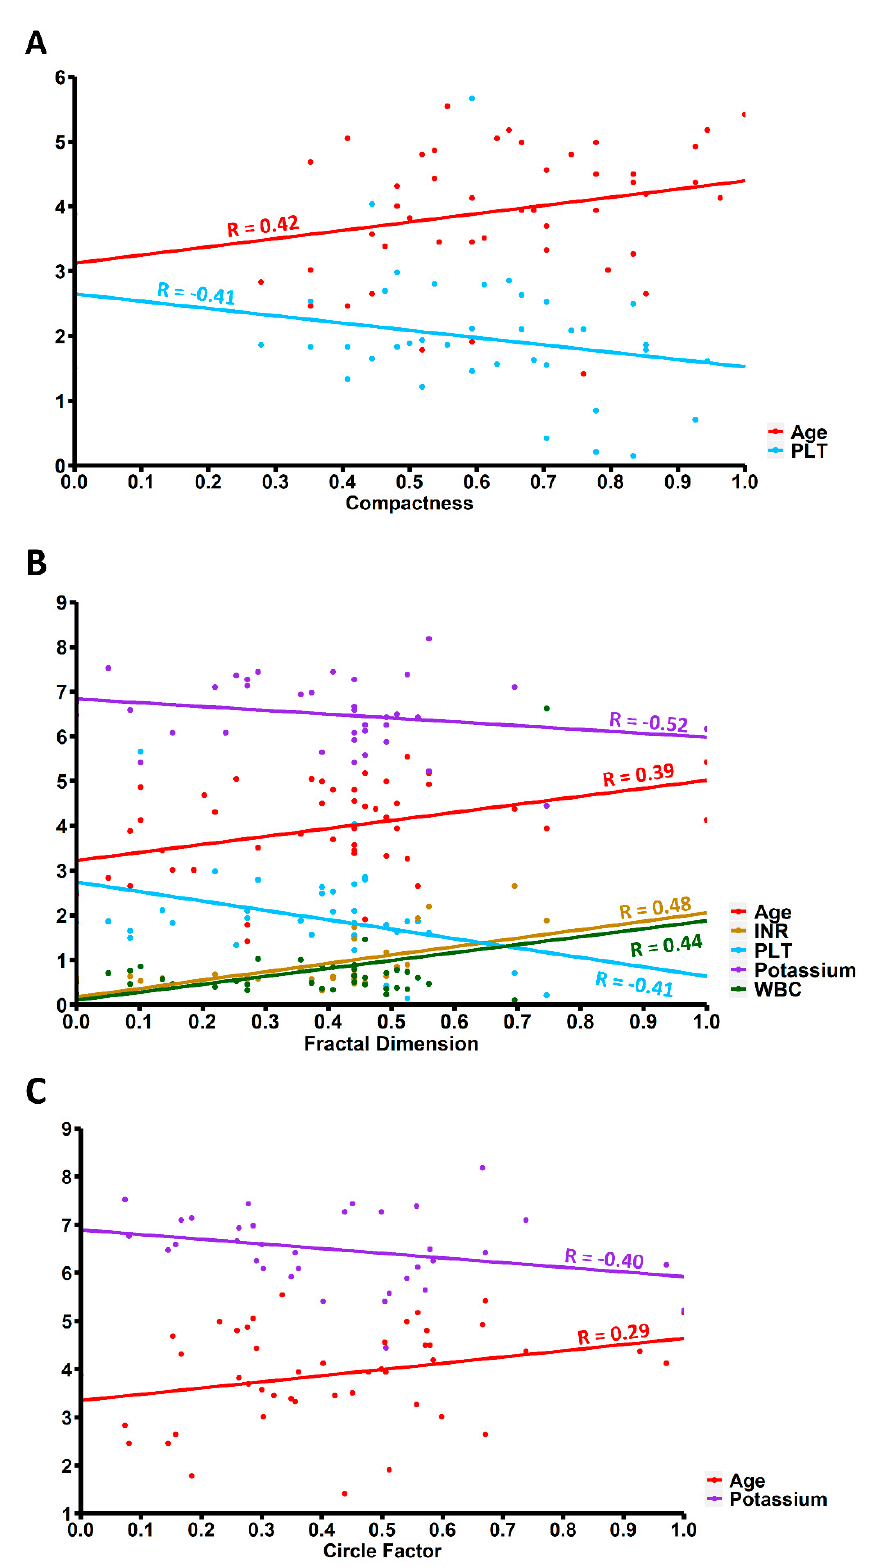
Figure 3. Correlation of age and blood test results upon admission with ( A ) Compactness, ( B ) Fractal Dimension and ( C ) Circle Factor. Values on x-axis are expressed as standard deviation units. WBC—White Blood Cells count, PLT—platelet count, INR—International Normalized Ratio.